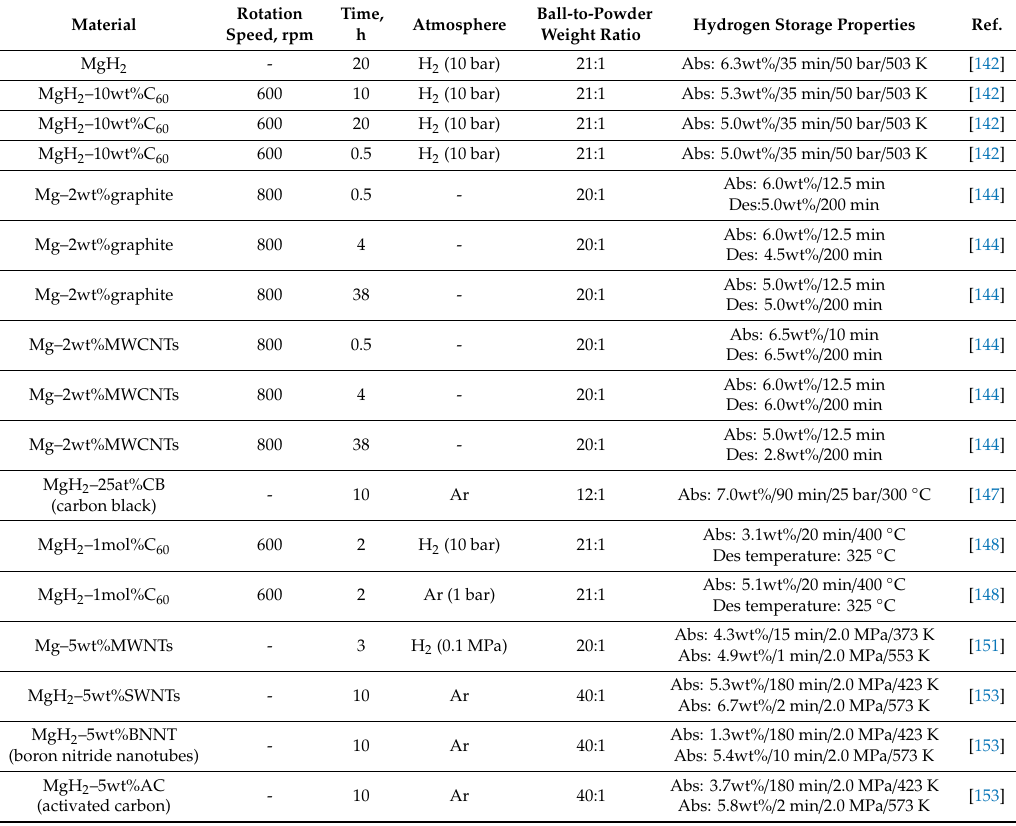
Table 5. Hydrogen storage properties of selected Mg modified by carbon